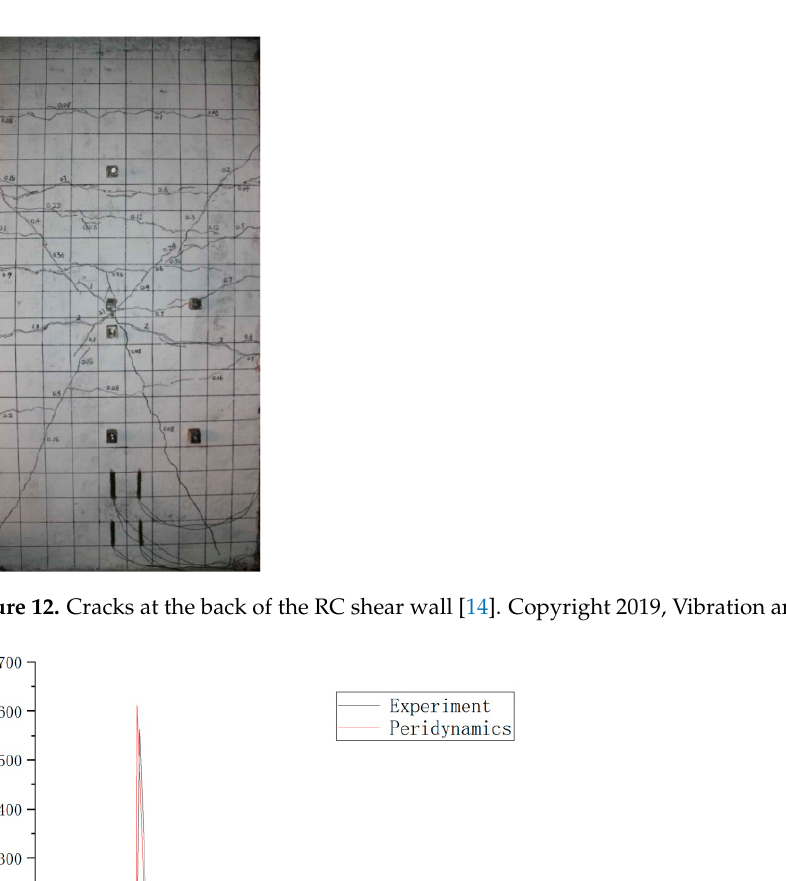
Figure 11. Crack development process at the back of the RC shear wall after falling hammer contact with the RC shear wall.